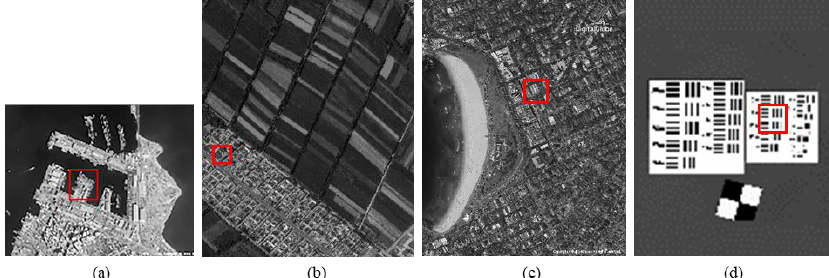
Figure 9. MS-CMOS conventional mode sampling simulation images: ( a ) seashore remote-sensing image, the chosen area is an offshore structure in an Egyptian port; ( b ) farmland remote-sensing image, the selected area is the crops and houses in Xinjiang, China; ( c ) city remote-sensing image, the selected area is buildings in Sydney; ( d ) target image, the selected area is minimum resolvable line pairs.